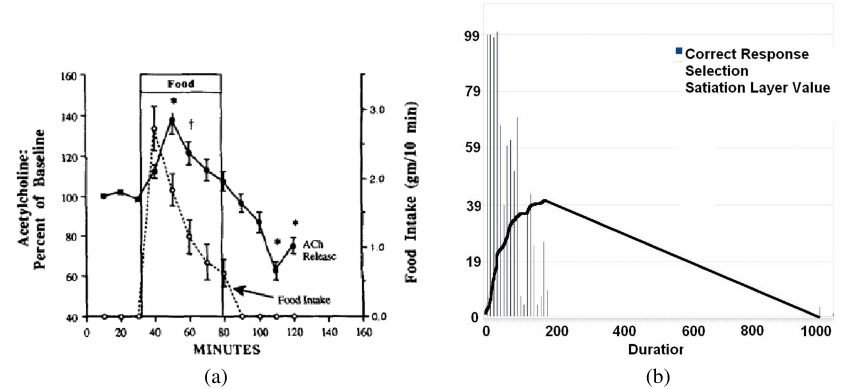
Figure 3. (Experimental) (a) Extracellular levels of ACh in the NAC before, during, and after five 10-min intervals of food access. Subjects ( n D 10 ) were deprived of food for 20 h before food presentation. ACh peaked in the 10-min interval imme- diately following maximal food intake ( (cid:3) p < 0:01 ; (cid:142)p < 0:05 ). ACh levels are expressed as the percent ( ˙ SEM) of the mean of three baseline samples [17]. (Simulation) (b) Graph showing the relation between feeding and the satiation layer value. The bars represent the number of correct responses in a session of 100 total responses. The line represents the satiation layer level in arbitrary